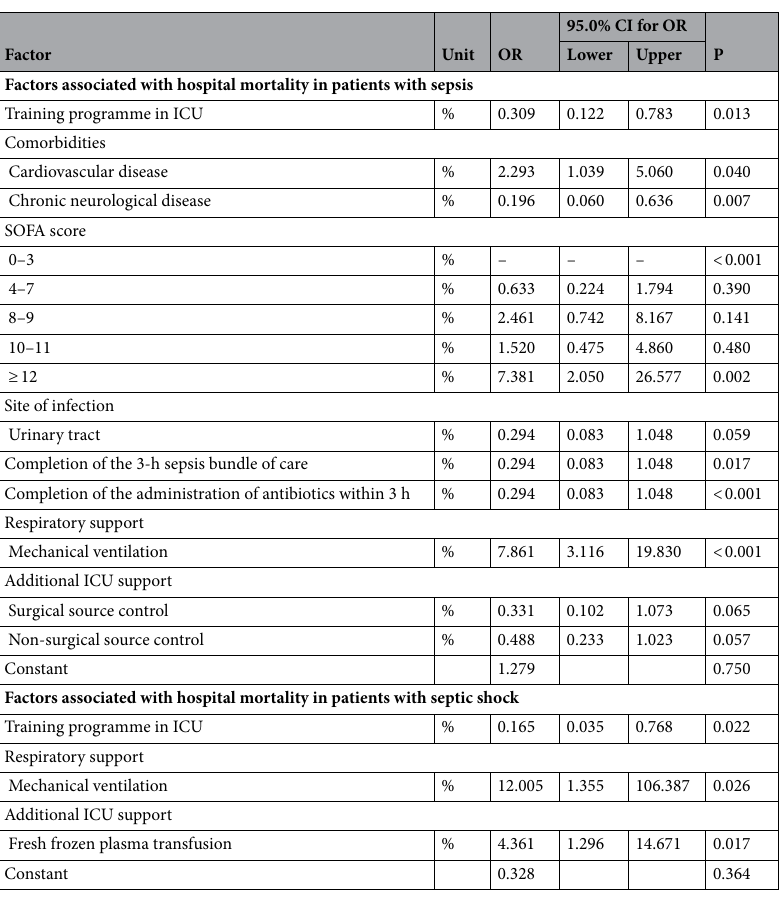
Table 7. Factors associated with mortality in patients with sepsis: multivariate logistic regression analyses. CI confidence interval, ICU intensive care unit, OR odds ratio, SOFA sequential organ failure